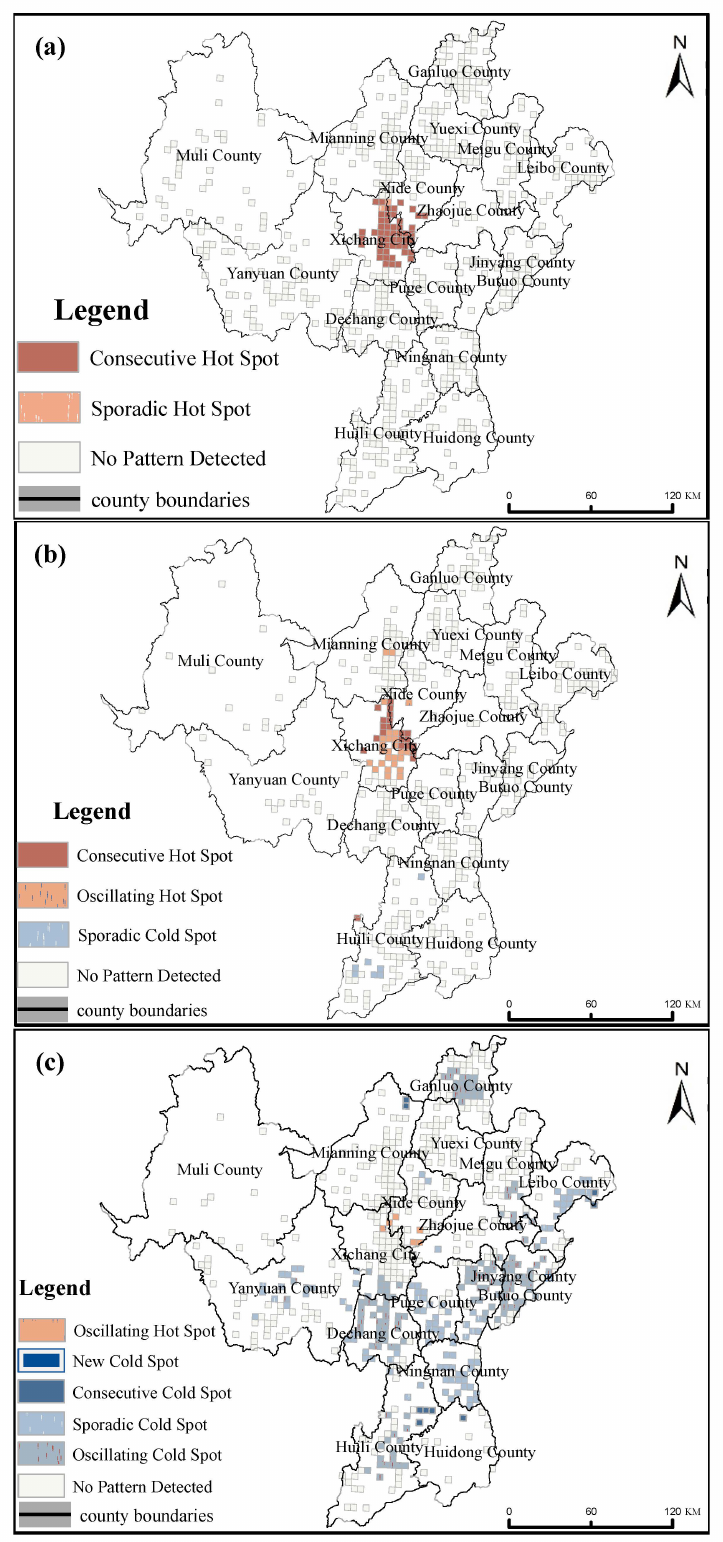
Figure 10. Spatio-temporal evolution pattern of crime: ( a ) Property crime; ( b ) Violent crime; ( c ) Special